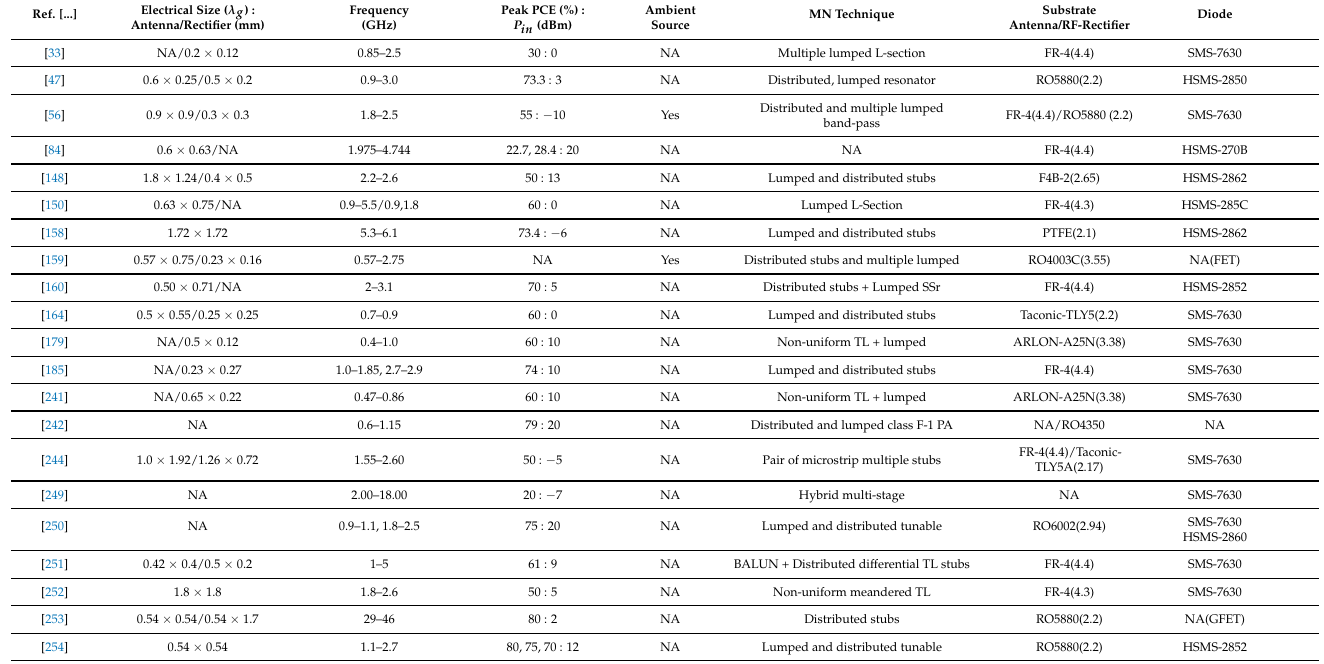
Table 5. Comparison of some basic broadband/wideband RFEH